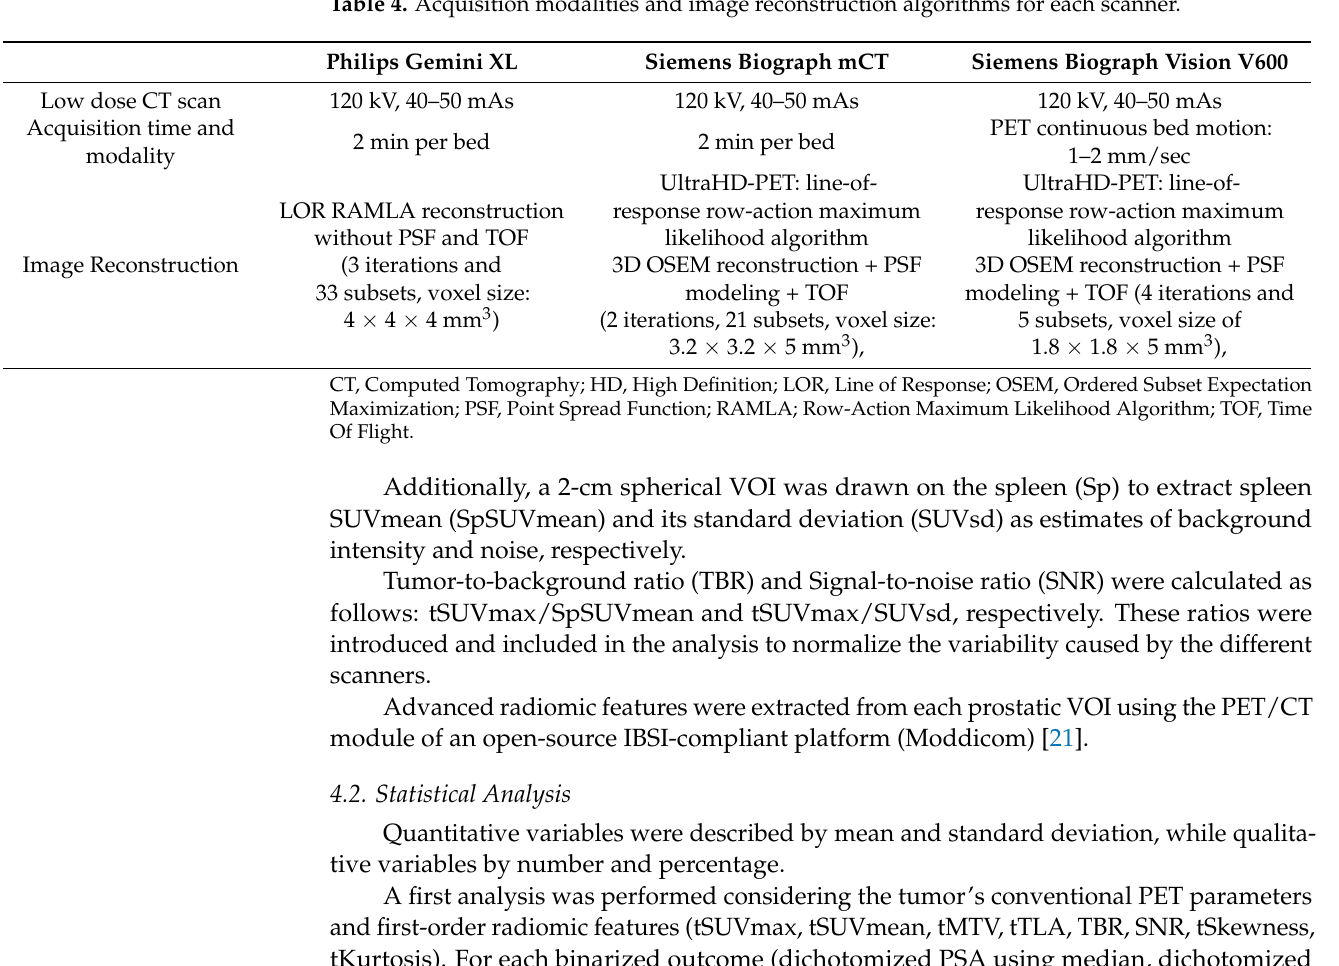
Table 4. Acquisition modalities and image reconstruction algorithms for each